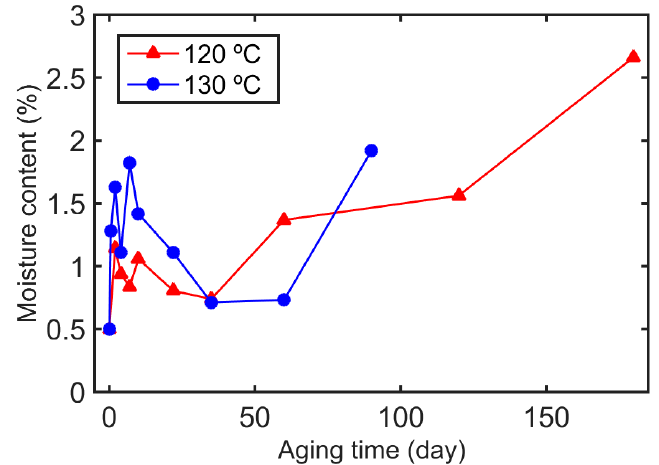
Figure 9. Moisture content of OIP.